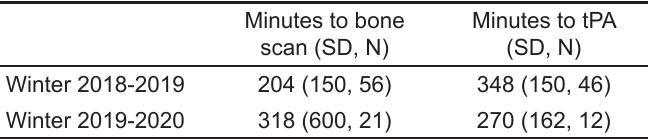
Table 2. Historical values of time taken to treat with tPA. Minutes to